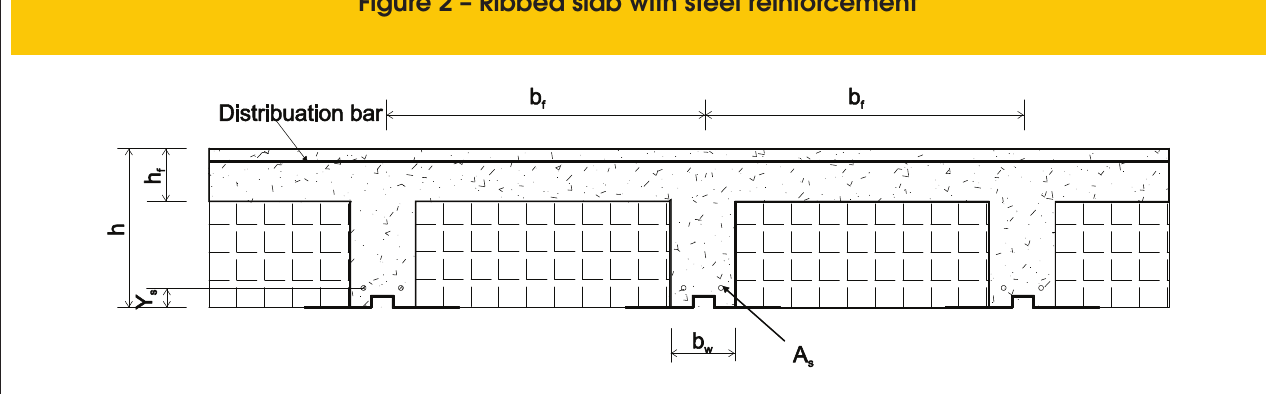
Figure 2 – Ribbed slab with steel